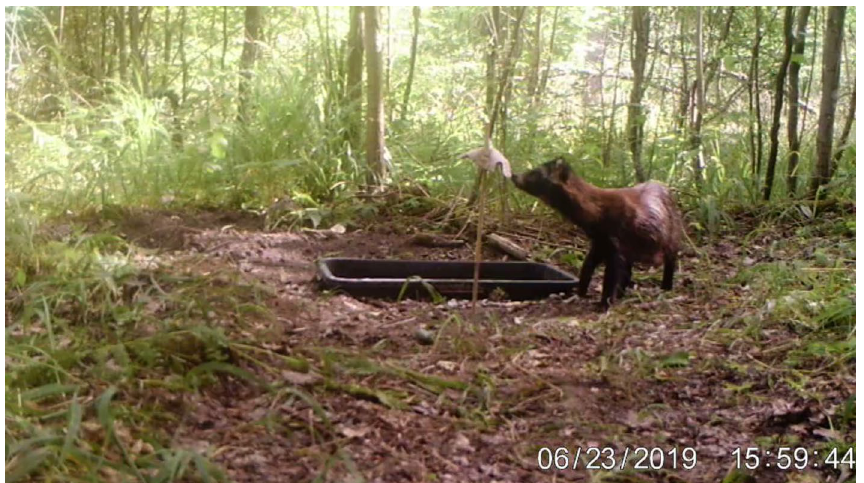
Figure 2. A still frame from a camera trap video showing our experimental set up. The picture shows a raccoon dog interacting with a treatment towel on the end of the bamboo stick with a feeding tray half buried in the ground